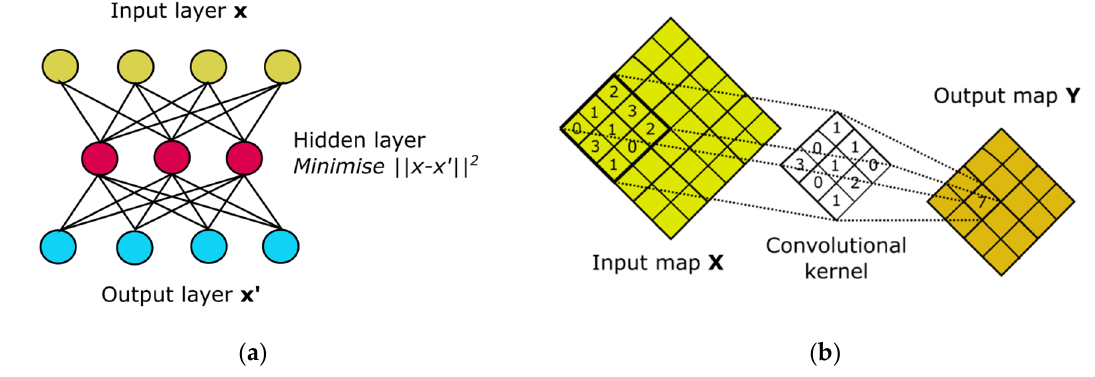
Figure 16. ( a ) Auto-encoder. ( b ) Convolutional neural network (based on [11]).